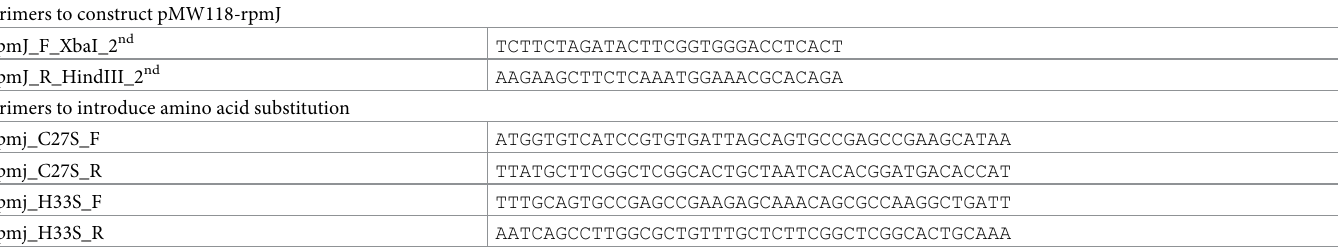
Table 3. Primers used in this